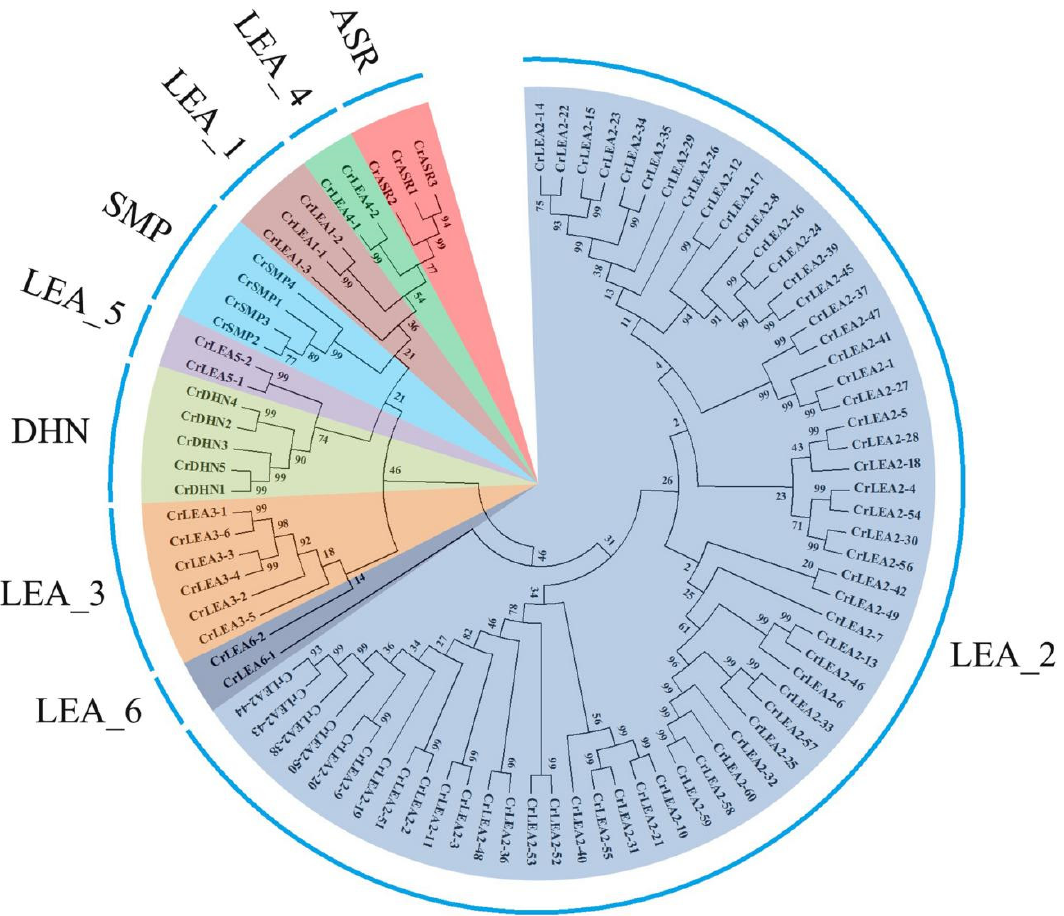
Figure 1. Phylogenetic analysis of the LEA and ASR proteins in Canavalia rosea . LEA and ASR subfamilies were distinguished by different colors. The unrooted tree was generated by ClustalW in MEGA6 with the sequences of the 87 C. rosea LEA and ASR proteins.